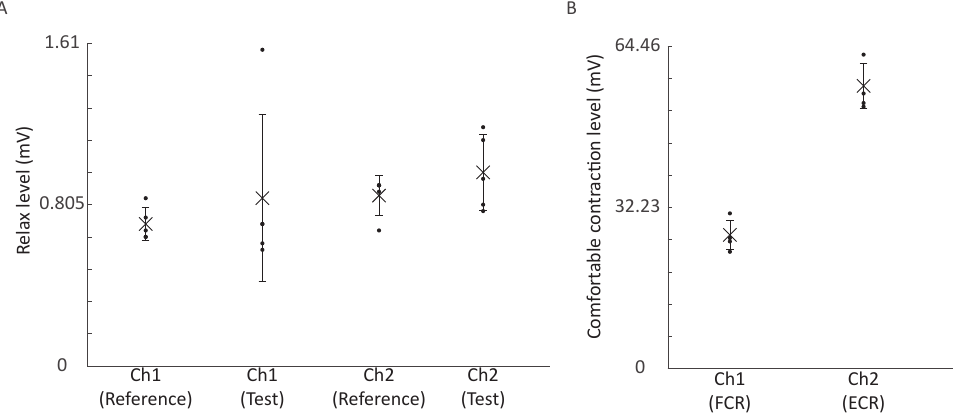
Figure 6. Mean absolute value (MAV) comparisons. ( A ) Comparison of the relaxed levels in the calibration (reference) and at the end of the day (test). ( B ) The comfortable contraction levels for two channels. Cross: mean; error bar: standard deviation; dot: individual data points (n =